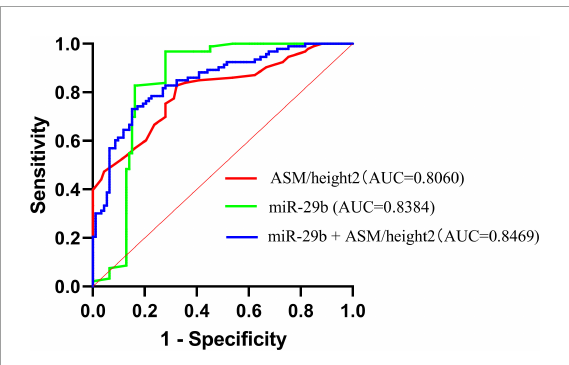
FIGURE5 Receiver operating characteristic (ROC) curve was used to evaluate the diagnostic value of miR-29b, ASM/height2, and combine miR-29b with ASM/height2 for sarcopenia in the elderly; n =